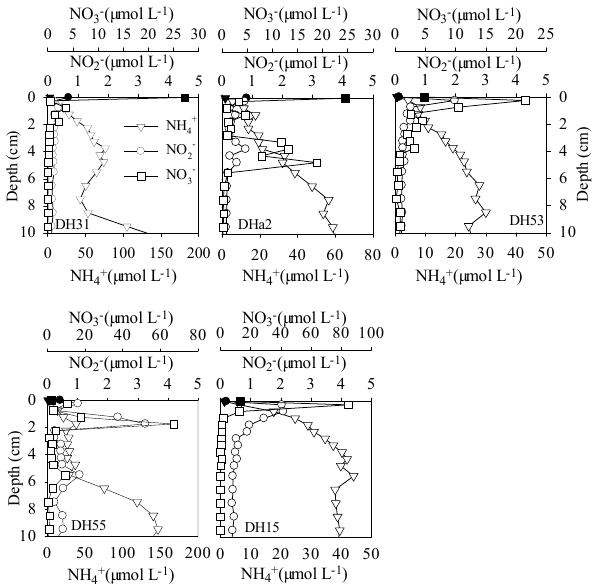
Fig. 2. Pore water profiles of NO 2 – , NO 3 – and NH 4+ in the East China Sea sediment. The black symbols represent overlying water data.